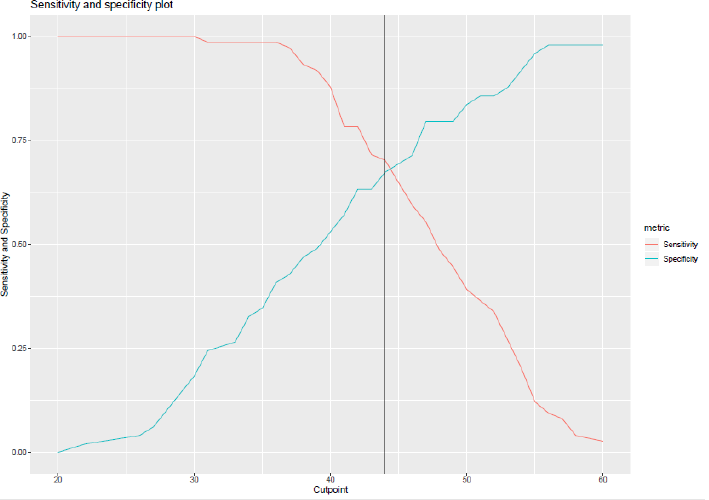
Figure 1. Identification of the cut-off point by crossing sensitivity and specificity.